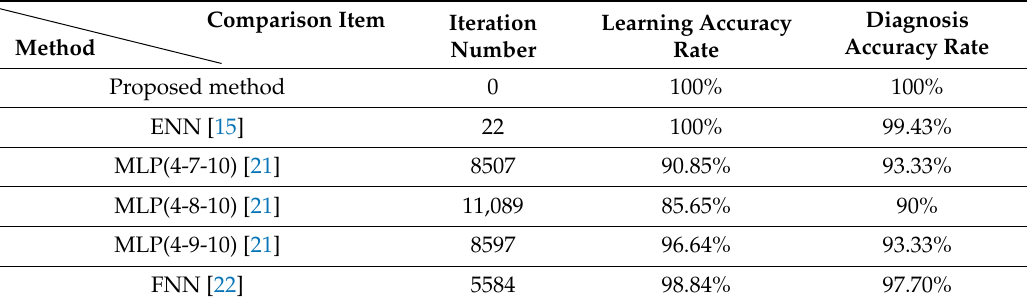
Table 2. Comparison of fault diagnosis accuracy rates when applied in a binary search-based method and the existing neural network